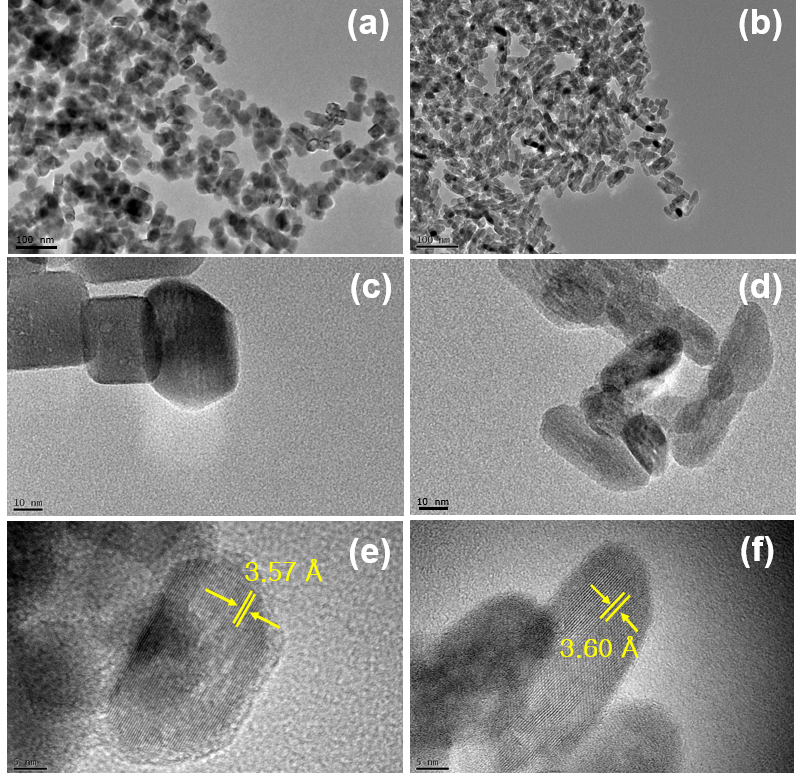
Figure 2. Corresponding TEM images of the YVO 4 :Eu 3+ nanoparticles grown using the precursor solutions with ( a , c , e ) for pH = 7 and ( b , d , f ) for pH = 10. Materials 2020 , 13 , x FOR PEER REVIEW